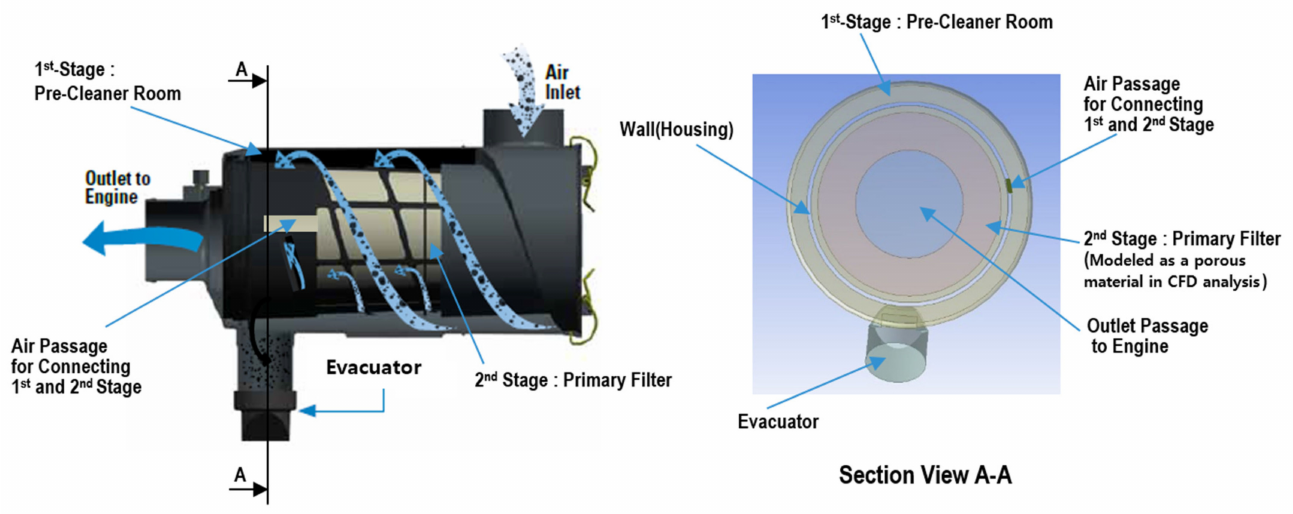
Figure 2. Air purification mechanism of a two-stage air cleaner